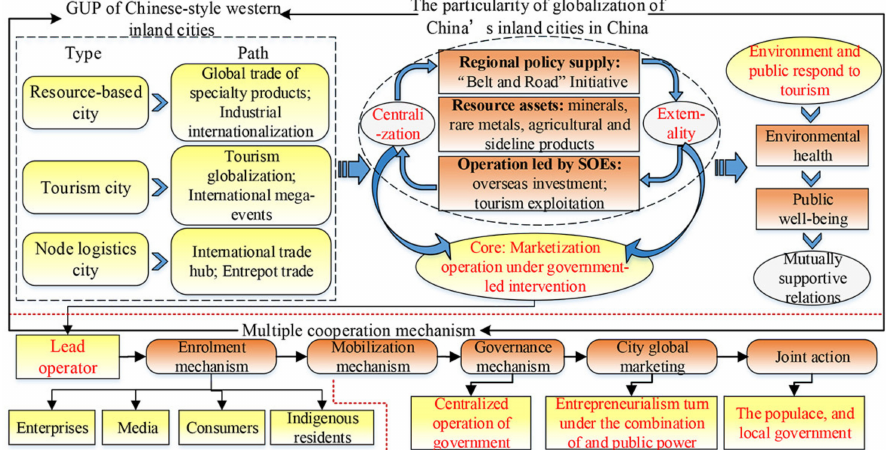
Figure 1. The conceptual framework of UGP of western inland cities in